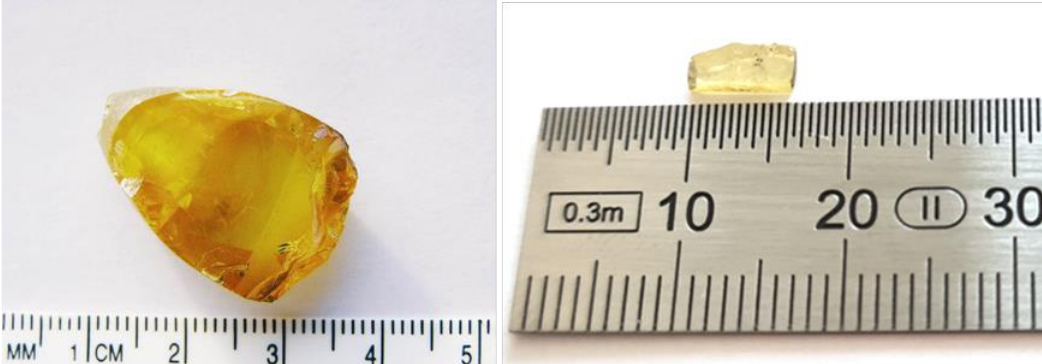
Figure 1. AgGaGeS 4 single crystal, synthesized using a modified Bridgman method ( left ); a cut and polished sample from the center of the boule used for spectroscopic studies ( right ).